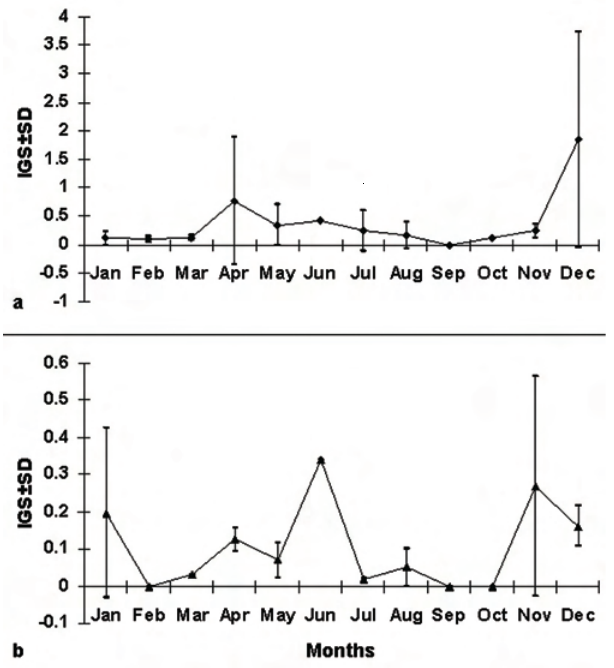
Fig. 8. Monthly variation of the mean values of GSI ± Standard Deviation (SD) of Cichla kelberi females (a) and males (b), in Lobo Reservoir, during the study period.